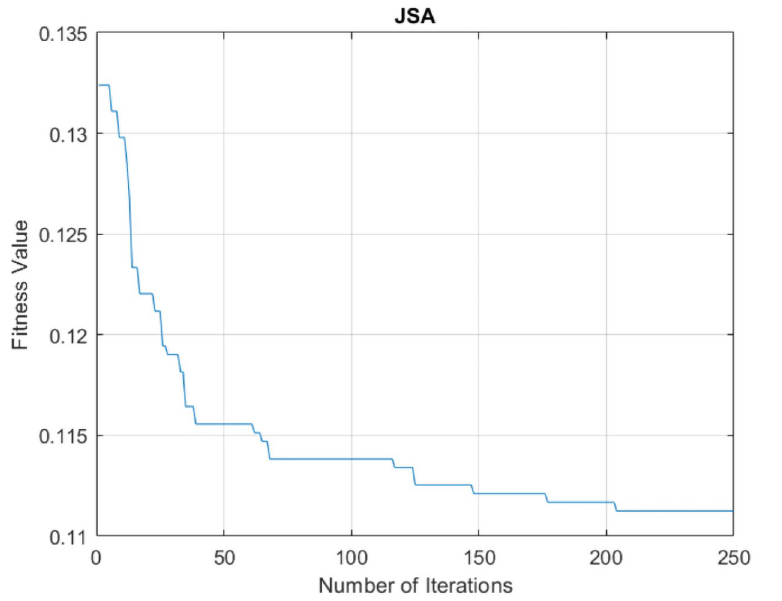
Fig 4. Convergence curve of feature selection process accuracy.